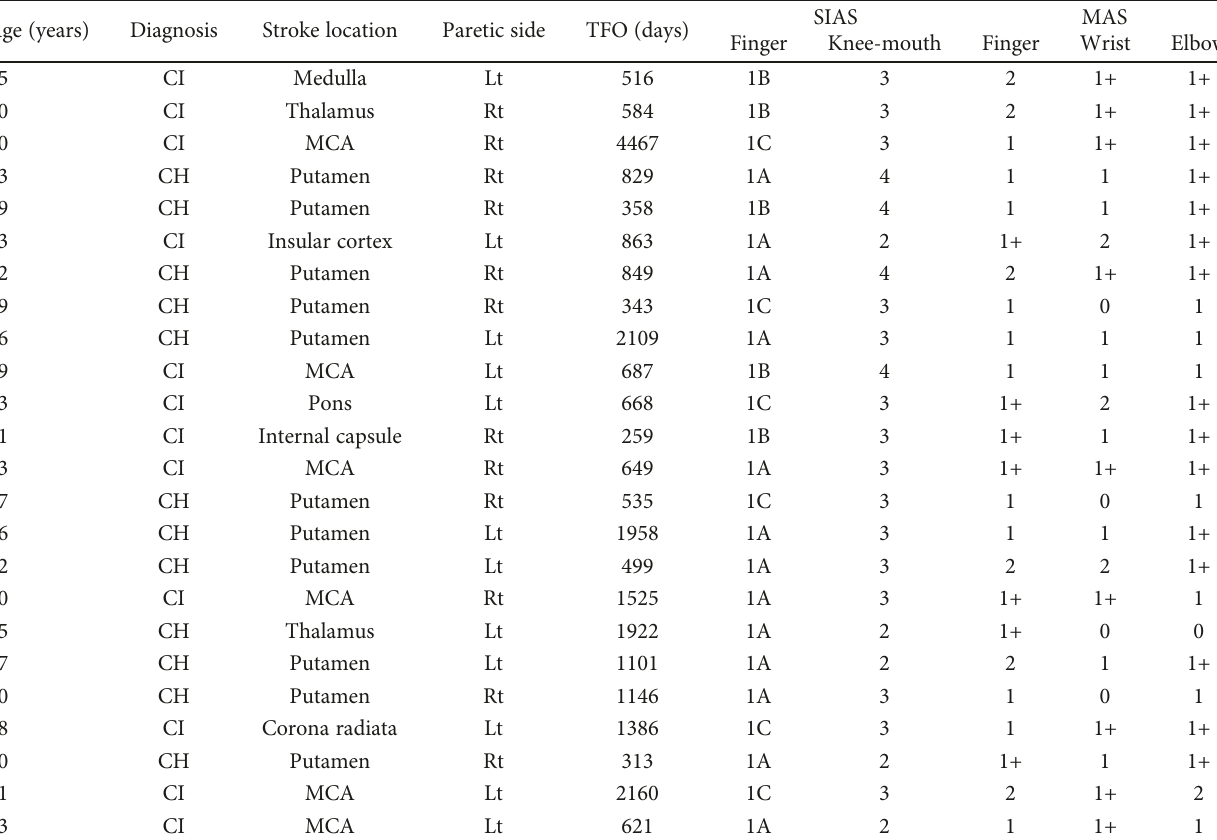
Table 1: Clinical details of participants in study